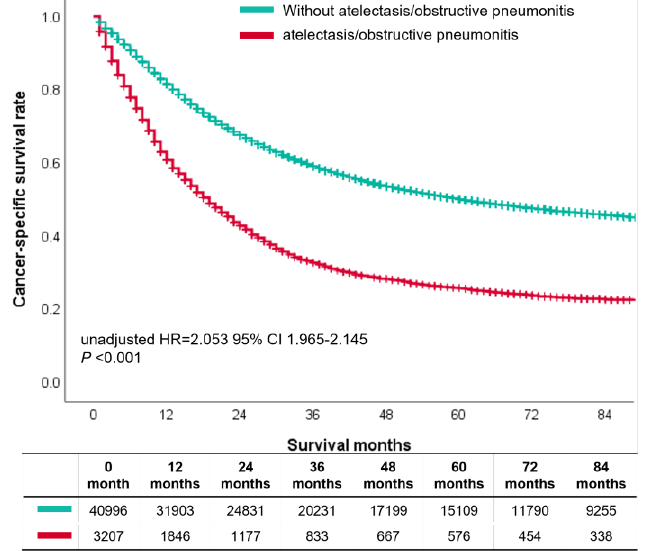
Figure 5. Stratified effect of the atelectasis/obstructive